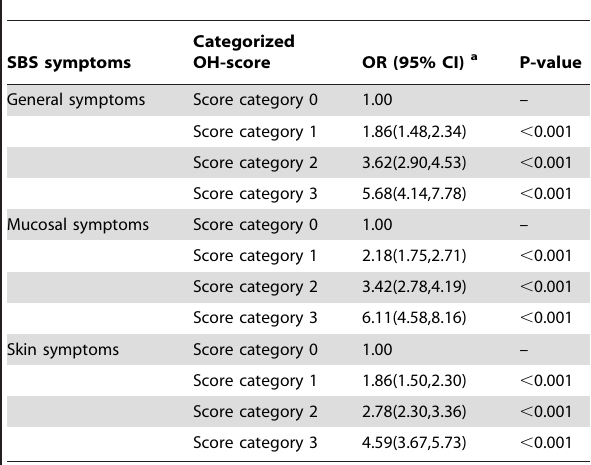
Table 7. Associations between SBS symptoms (weekly or sometimes) and Categorized OH-score